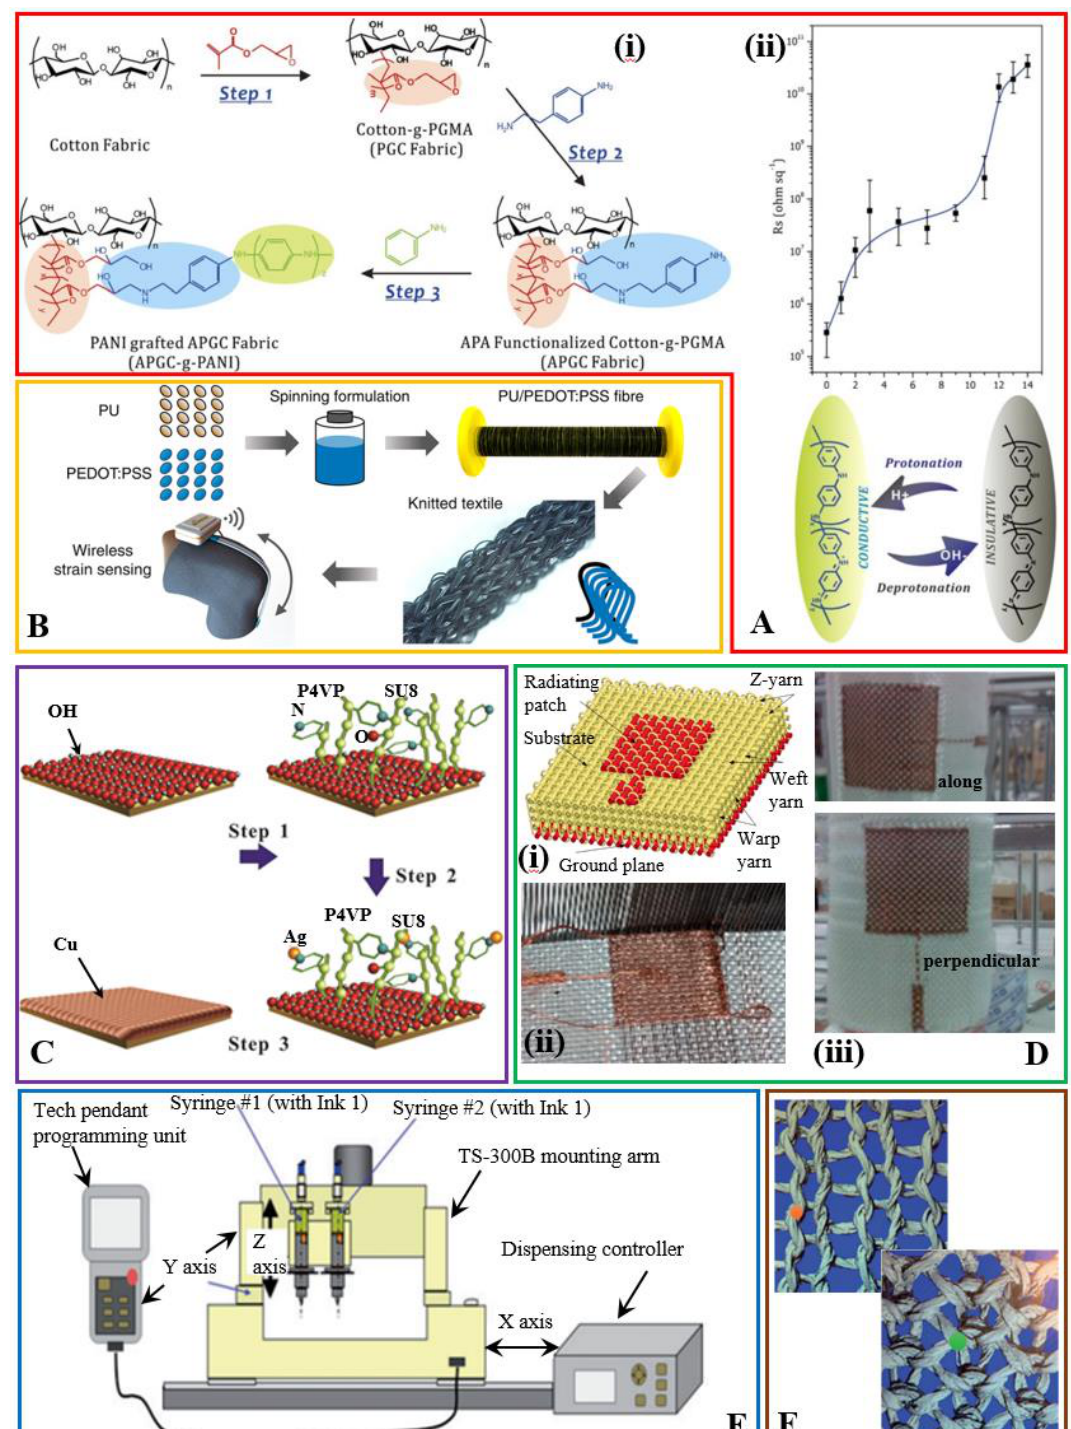
Figure 1. Textile antennas. ( Ai ) Preparation of the conductive textile by chemical grafting of polyaniline (PANI) onto cotton fabrics. PANI is linked to cotton fibers through two chemical modifications of the side chain of fibers. ( Aii ) The sheet resistance of the conductive fabric after immersing in bath solutions with different pH values. The inset schematic shows the transformation between emeraldine base (insulating form) and emeraldine salt (conductive form) by H + protonation and OH − deprotonation of PANI chains. Reproduced with permission from [20]; Copyright 2015, Nature Publishing Group. ( B ) The schematic illustration shows the preparation of polyurethane (PU)-based conductive fibers after mixing the solution of PU with the poly(3,4-ethylenedioxythiophene) polystyrene sulfonate (PEDOT:PSS) fillers followed by a spinning process. Reproduced with permission from [23]; Copyright 2015, American Chemical Society. ( C ) Schematic illustration of the electroless deposition of copper on cotton fabrics. Step 1: poly(4-vinyl pyridine) (P4VP) is first attached to cotton fabrics by dip coating. Step 2: silver ions are absorbed due to the strong affinity of pyridyl groups to metals. Step 3: silver ions are reduced to silver particles, which will act as the catalyst for the copper deposition. Reproduced with permission from [36]; Copyright 2016, Royal Society of Chemistry. ( Di ) Schematic and ( Dii ) weaving process of the 3D fabric antenna. ( Diii ) Optical images show the bending of 3D fabric patch antennas with the curvature along with or perpendicular to the feeding direction. Reproduced with permission from [39]; Copyright 2016, SAGE Publications. ( E ) Patterning of conductive traces on textile substrates with an automatic dispensing system by sequent dispensing of copper sulfate (CuSO 4 ) and sodium borohydride (NaBH 4 ). A conductive copper film forms after the redox reaction. Reproduced with permission from [40]; Copyright 2014, SAGE Publications. ( F ) Micro-computed cosmography images of conductive fabrics with different knitted structures. The contact resistance of the top (plain knit, the interlock of the knit stitches) is contributed by the overlap of two conductive yarns, whereas that of the bottom (single pique with 50% tuck stitch, the interlock of the knit stitch and the tuck stitch) is from three conductive yarns. The latter one with more conductive pathways has a smaller contact resistance. Reproduced with permission from [41]; Copyright 2018, SAGE Publications. The sheet resistance of the textile also depends on the design and process of knitting or weaving. As shown in Figure 1F, the conductive fabric in the single pique structure (orange dot in the bottom one) with more conductive pathways has a smaller contact resistance than the plain knit